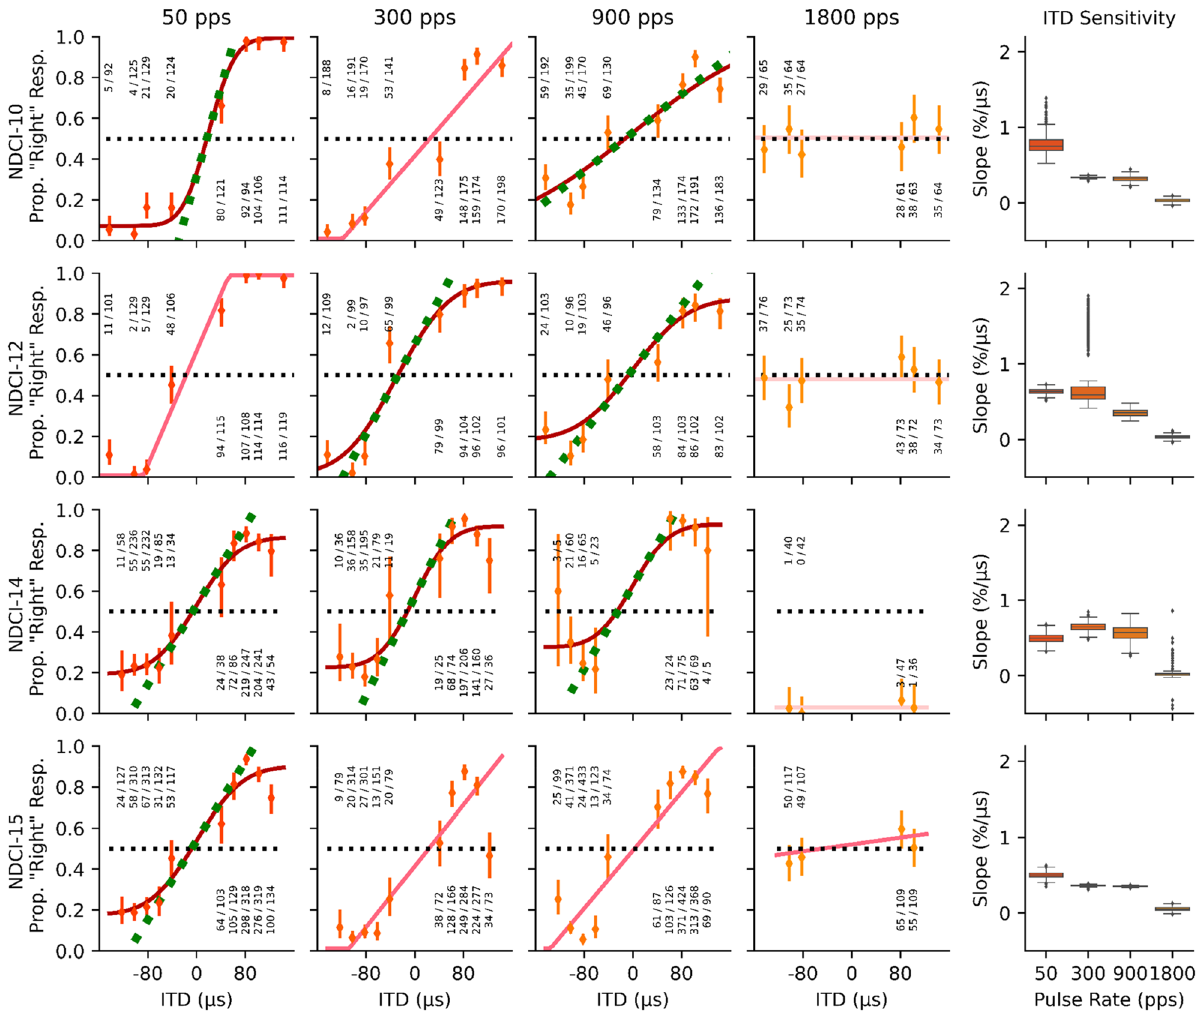
Figure 3. Psychometric curves for the same four example neonatally deafened, cochlear implanted (NDCI) rats as shown in Fig. 2 localizing Hanning windowed pulse trains with varying interaural time differences (ITDs). Details are as for Fig. 2. Psychometrics of all CI animals tested on Hanning windowed stimuli are shown in Fig.